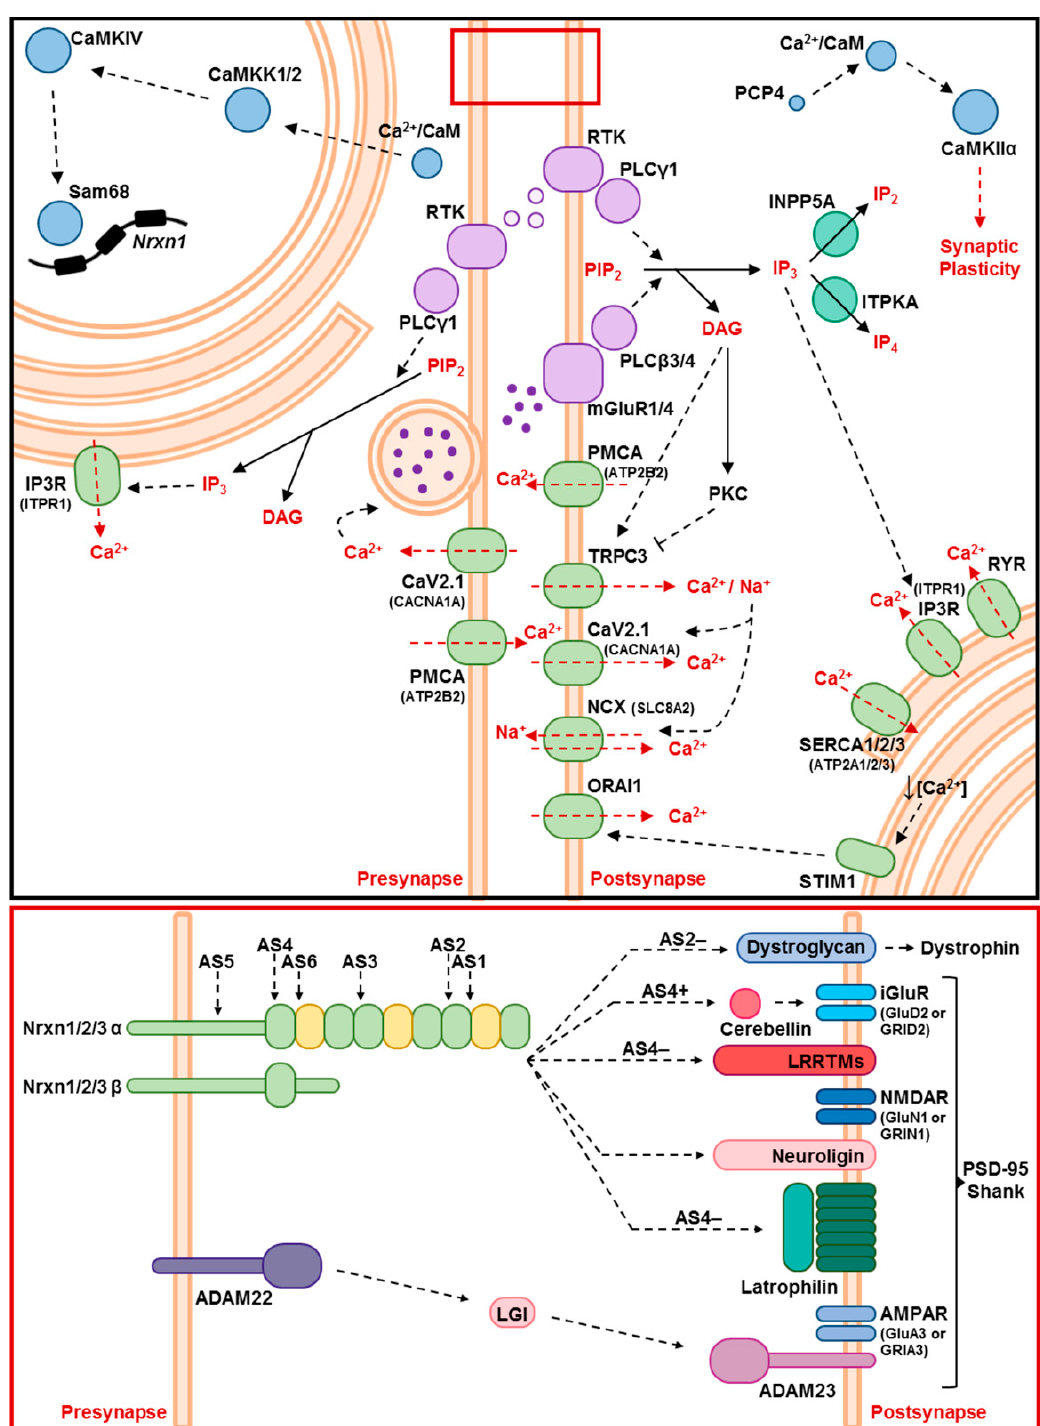
Figure 8. Schematic representation of the Ca 2 + associated signaling cascades and synaptic integrity components investigated in the framework of this project. Bottom panel corresponds to red inset in top panel. Neurexin structure and preferential interactions were adapted from Südhof T.C. 2017